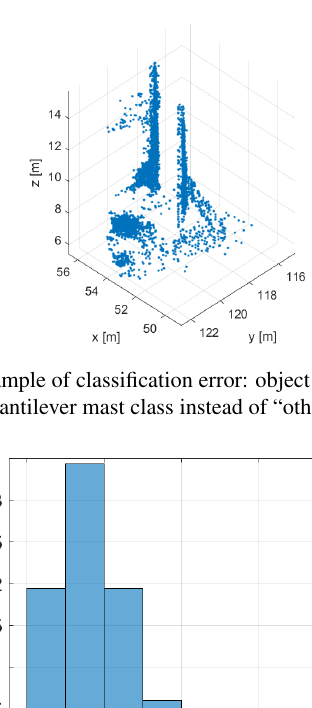
Figure 8. Examples of classification errors: objects classified as (a) portal, (b) “other”, instead of cantilever mast.